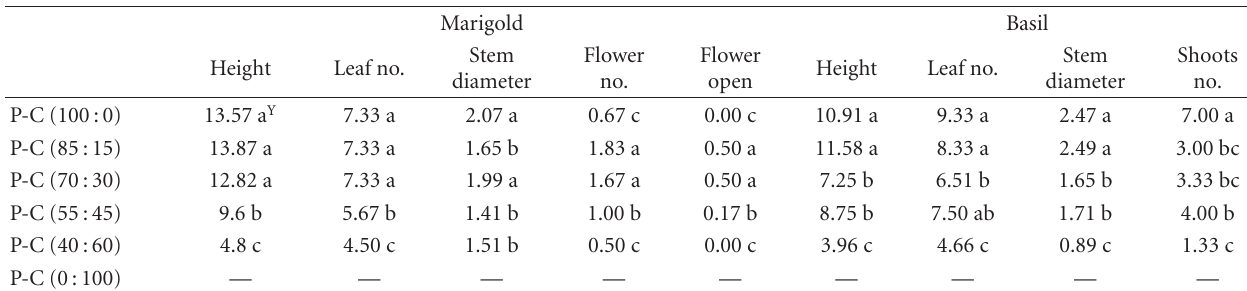
Table 1: Influence of substrate medium (commercial peat: CP; municipal solid waste compost:MSWC) at di ff erent ratios on seedling height (cm/plant), number of leaf produced, stem diameter (mm), number of flower produced and opened, and number of lateral shoots on marigold and basil plant grown in greenhouse nursery.